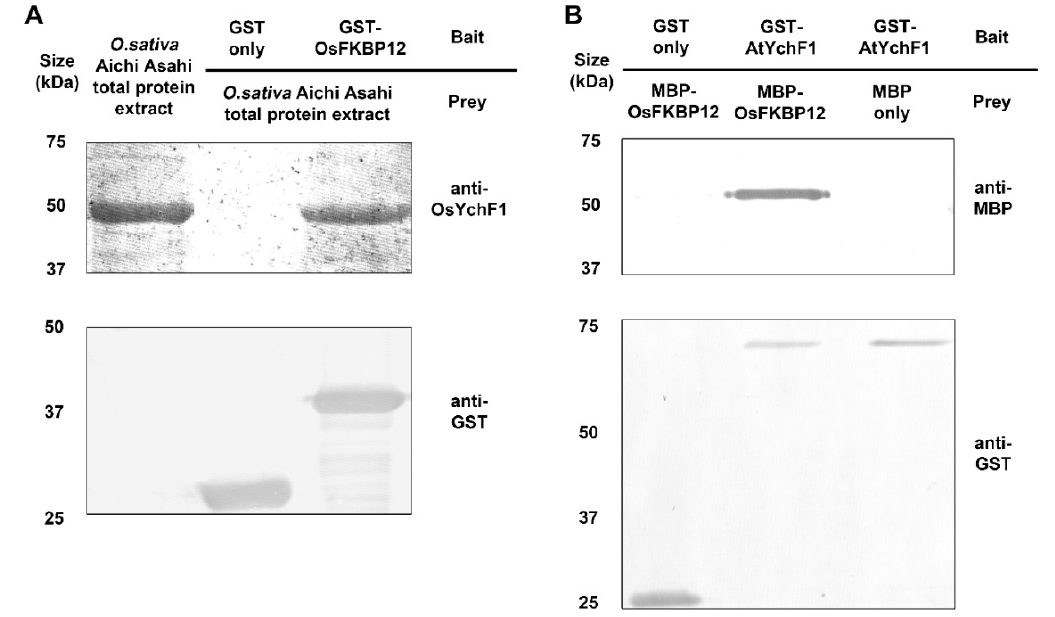
Figure 5. In-vitro pull-down experiments of OsFKBP12 with YchF1 homologs from rice and Arabidopsis. ( A ) In-vitro pull-down of OsFKBP12 with the native unconventional G-protein OsYchF1. Around 500 μ g total protein extracted from Aichi Asahi rice strain was mixed with 100 μ g GST-tagged proteins or GST tag only. The MagneGST TM Glutathione Particles were used for pulling down the protein complex, followed by western blot detection using anti-OsYchF1 antibodies and anti-GST antibodies. ( B ) In-vitro pull-down of OsFKBP12 with the Arabidopsis homolog of OsYchF1, AtYchF1. Around 100 μ g cell lysate containing GST-tagged proteins were mixed with 100 μ g cell lysate containing MBP-tagged proteins. The MagneGST TM Glutathione Particles were used for pulling down the protein complex, followed by western blot detection using anti-MBP and anti-GST antibodies. MBP tag alone and GST tag alone were used as negative controls to confirm the specificity of the interactions. The experiment was performed twice with similar results.